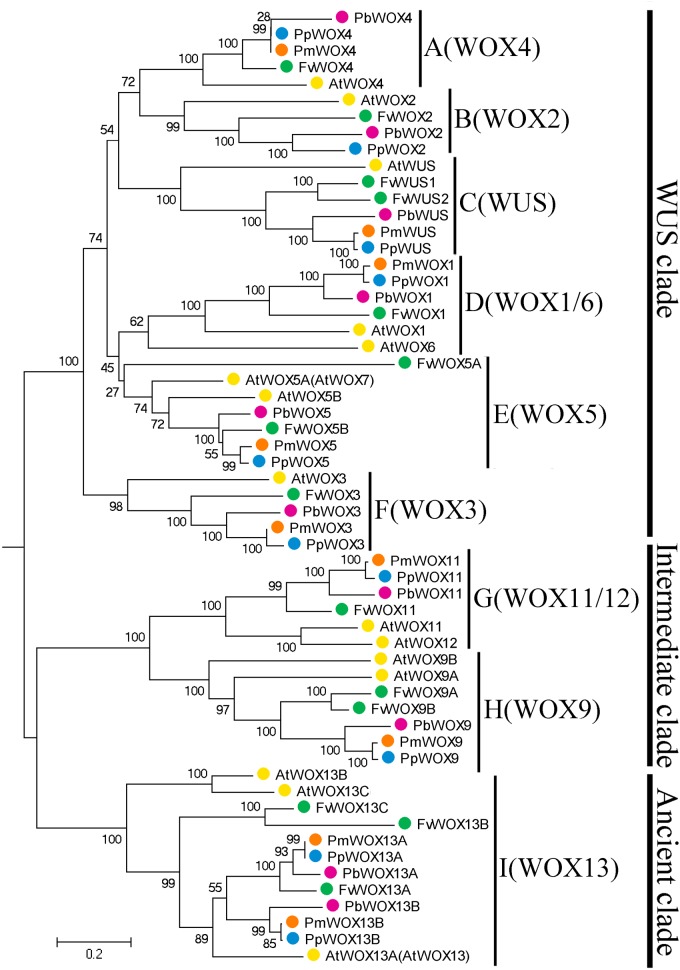
Neighbor-Joining tree of WOX family members in four Rosaceae species, F. vesca (Fv, green), P. mume (Pm, orange), P. persica (Pp, blue), and P. bretschneideri (Pb, red). Numbers indicate bootstrap support for branches. The clade I WOX genes (and only this group) are found both in some green algae and in all land plants, and so provide a root for this tree.